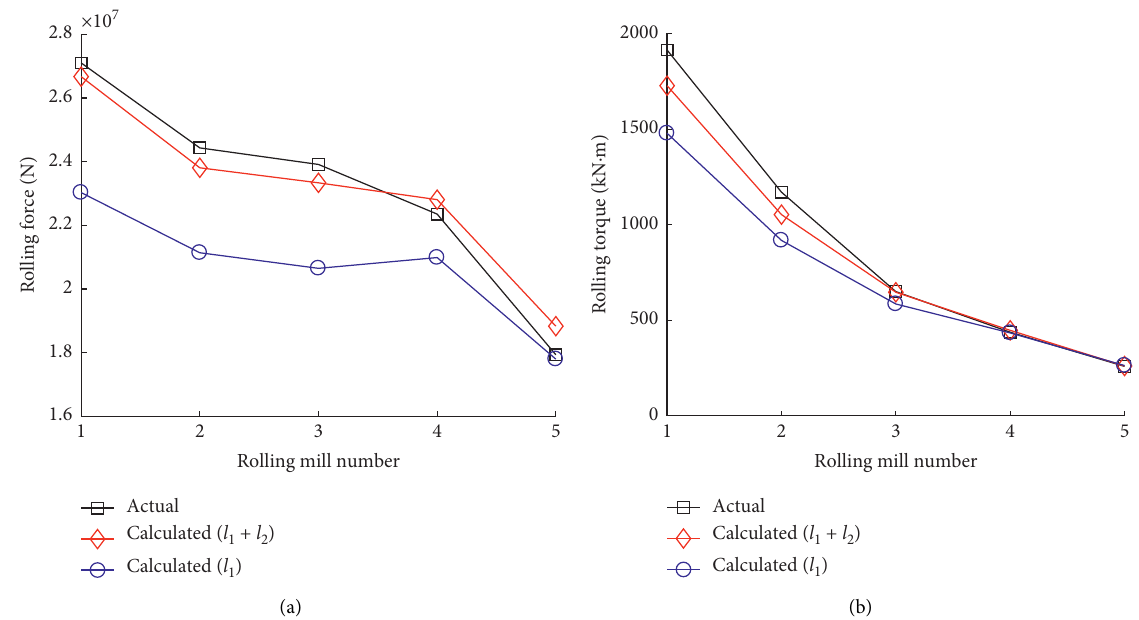
Figure 3: Comparison between the actual parameters and calculated parameters: (a) rolling force; (b) rolling